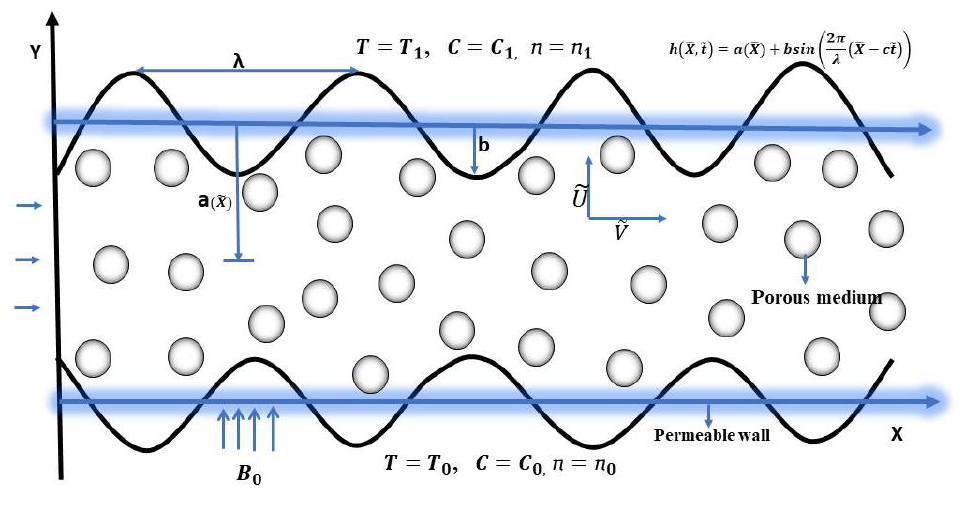
Figure 1. Geometry of the physical model.